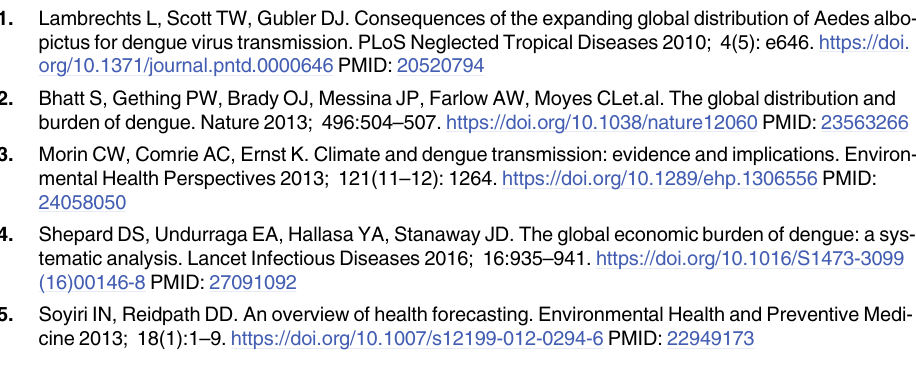
S1 Fig. Weekly total counts of confirmed dengue cases over Colombia for 2014–2018 and the predicted counts of dengue cases by the national three-, five-, six-, seven-, nine-, and eleven-week-ahead models for 2018. S2 Fig. Accuracy comparison between the local and the national random forests models at the department scale for each week ahead predictions using the relative mean absolute error